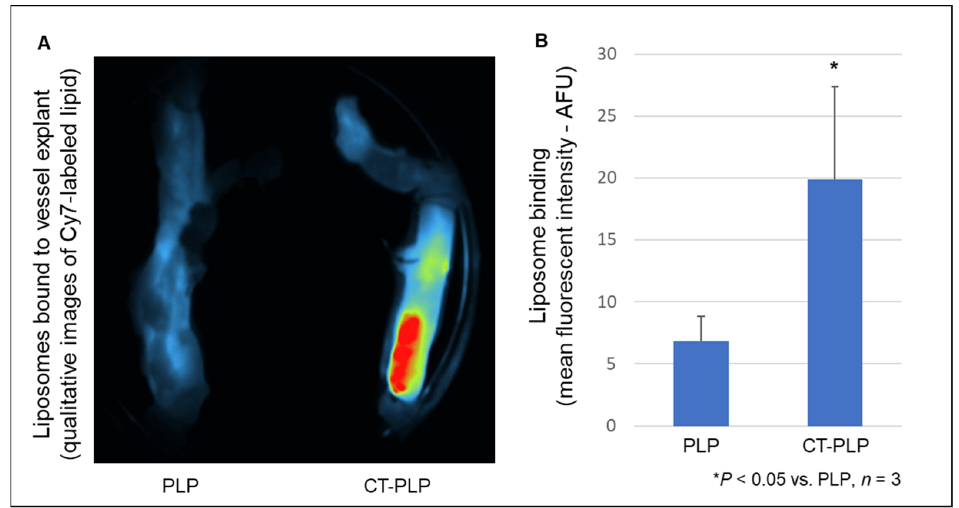
Figure 8. CT-PLP binding was significantly increased over PLP controls in human lower extremity vessel explants under ex vivo vascular perfusion. ( A ) Representative near-infrared (NIR) images showing Cy7-labeled liposomes bound to saphenous vein segments after 30 min continuous ex vivo perfusion. ( B ) After 30 min of a continuous flow, CT-PLP binding was significantly increased over PLP controls. Binding was detected using in vivo imaging system software to quantify fluorescent intensity per vessel area, and data were presented as the mean fluorescent intensity normalized to the fluorescent intensity of the background of non-perfused control vessels.